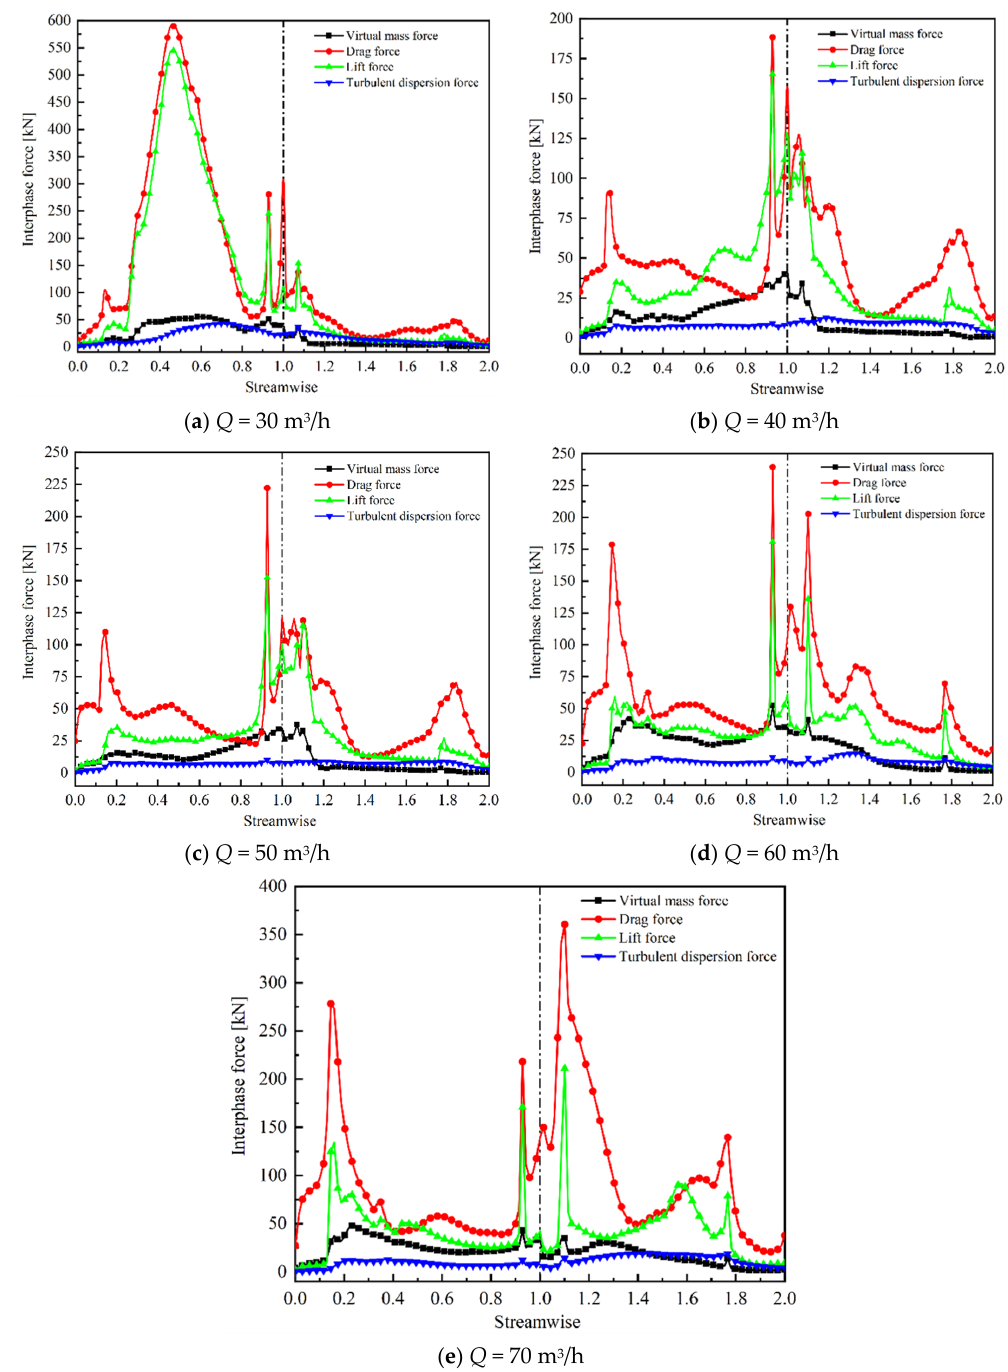
Figure 12. Analysis of interphase force under different flow rates ( Q = m 3 /h).